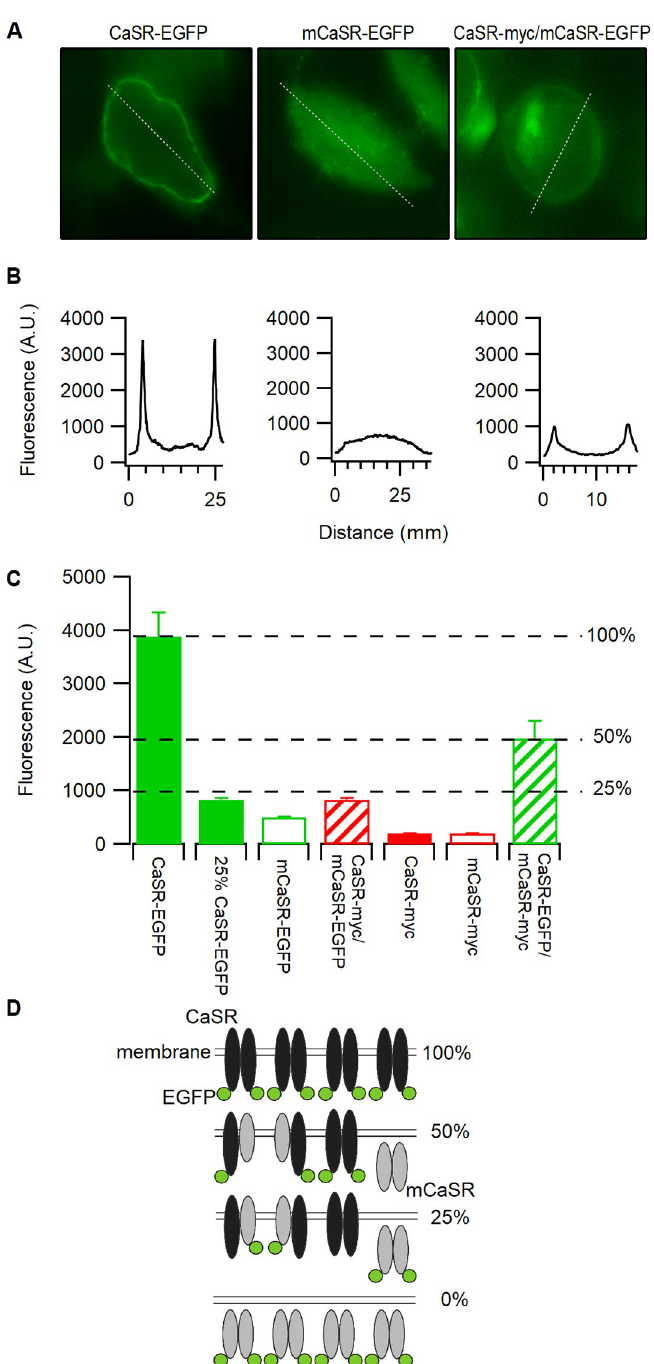
Fig 5. Cell surface expression levels of wild-type and mutant CaSR. A, EGFP fluorescence of HEK 293 cells transfected with pEGFP/CaSR, pEGFP/mCaSR, or pEGFP/mCaSR and pcDNA-myc/CaSR. The white line across the cell center and membrane is used to measure the receptor expression tagged with EGFP fluorescence. B, EGFP fluorescence analyzed using Wasabi image software to measure the fluorescence along the line of interest (broken white line) shown in A. The peak fluorescence was used as the cell surface expression of EGFP tagged receptor. C, cell surface receptors in HEK 293 cells transfected with 0.25 nM or 0.06 nM vector using the combinations shown in the Figure. By tagging either the wild-type or mutant receptors we measured relative efficiencies of expression of the wild- type and mutant CaSR in the membrane. Each histogram bar represents the average measurements from three separate coverslips (approximately 20 cells on each coverslip). Values are means ± SEM. D, Model illustrating that